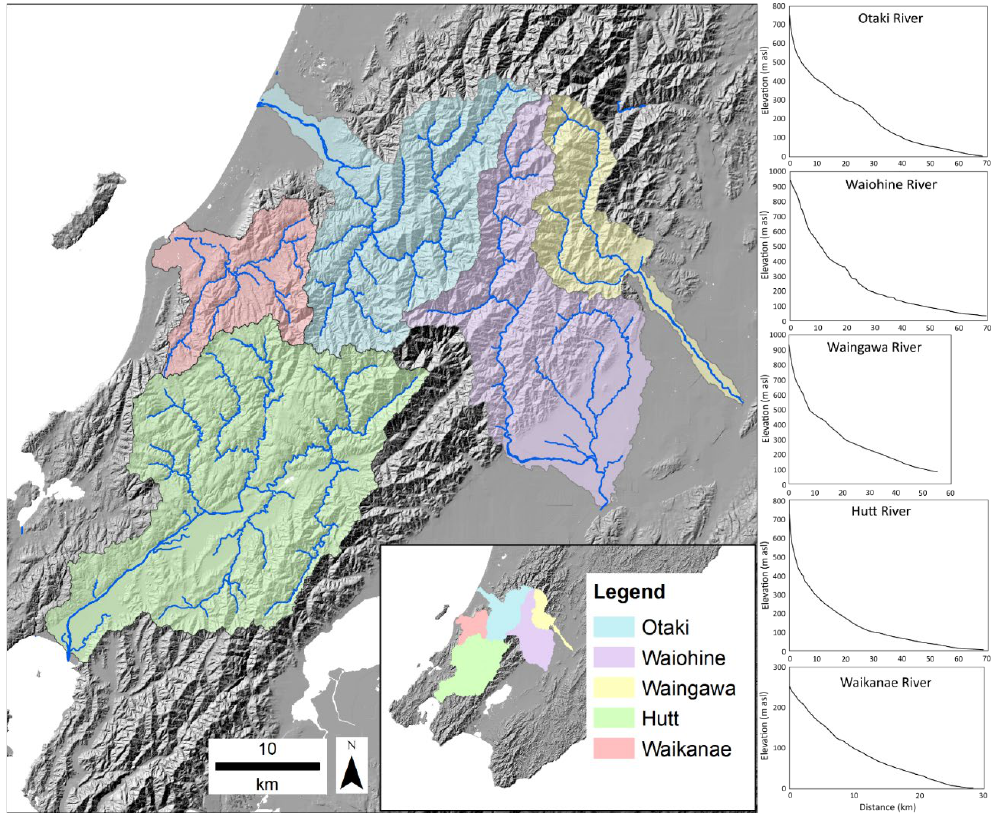
Figure 3. Bed elevation profiles for selected Greater Wellington Reg ion catchments: Ōtaki, Wai- ohine, Waingawa, Hutt, Waikanae.